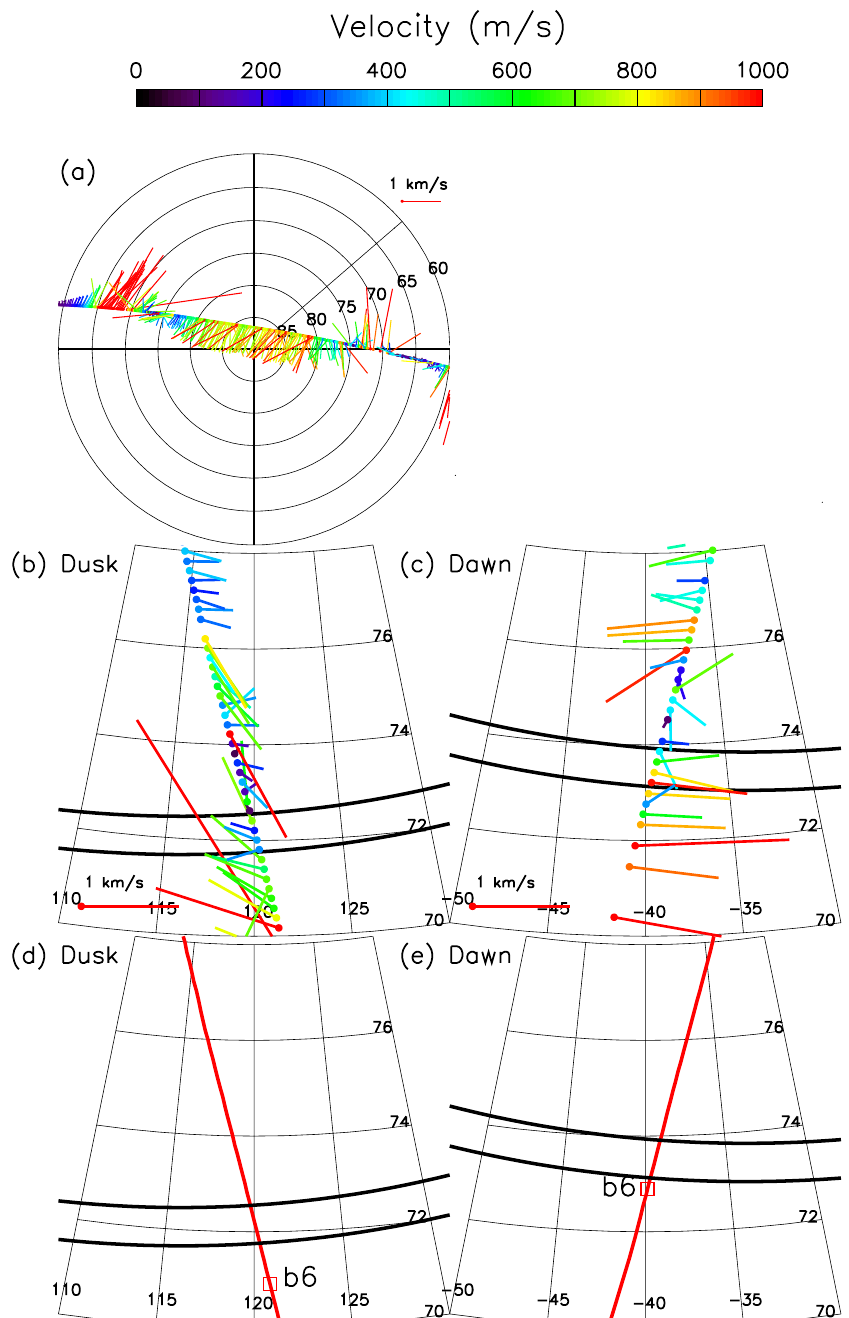
Fig. 5. Observations of the plasma drift by DMSP F13 satellite (at 845km altitude) around 13:30 UT. The cross-track and ram direction data have been combined to produce a vector. Panel (a) shows all the data from the transit of the northern polar cap. Panels (b) and (c) show sections of the afternoon and morning plasma flows respectively. The bold lines show the polar cap boundary used in our measurements. The b6 particle precipitation boundary (see text) is marked in panels (d) and (e) with a red square.